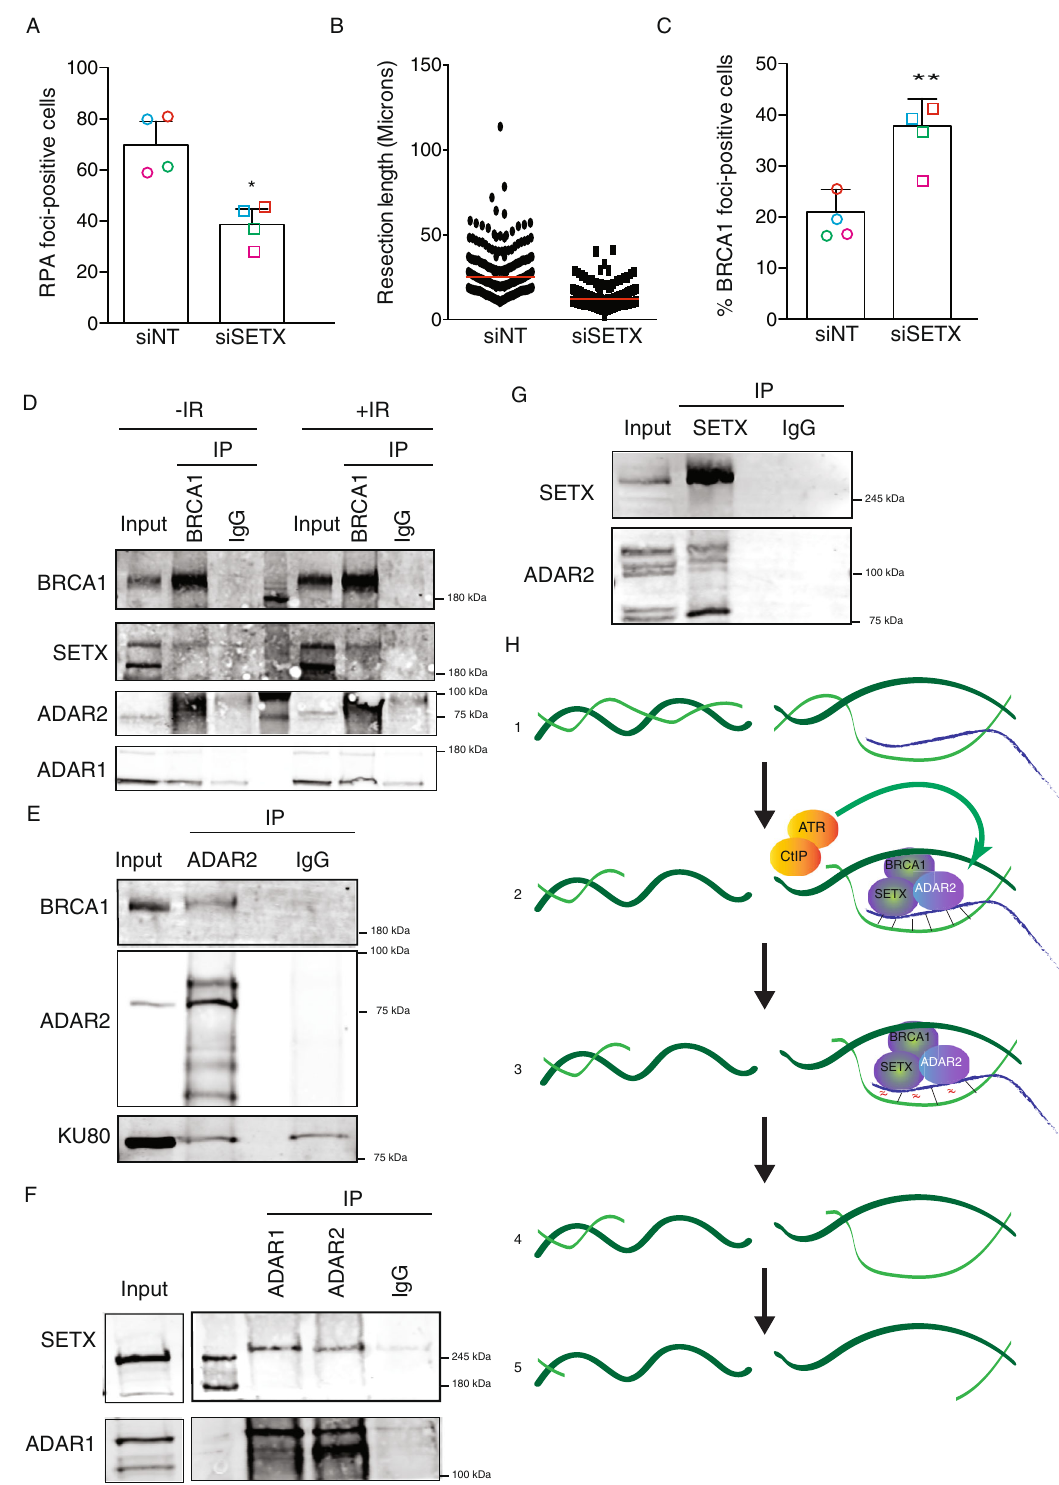
DNA:RNA hybrids and R-loops increase, as previously described by other authors 13 – 16 , and many of them speci fi cally accumulate at break sites. Although some authors argue that these structures they act as roadblocks for repair (for a review see ref. 37 ). This contradiction might simply stem from a differential effect of DNA:RNA hybrids depending on the timing of repair, i.e. very early events might need them but later they have to be